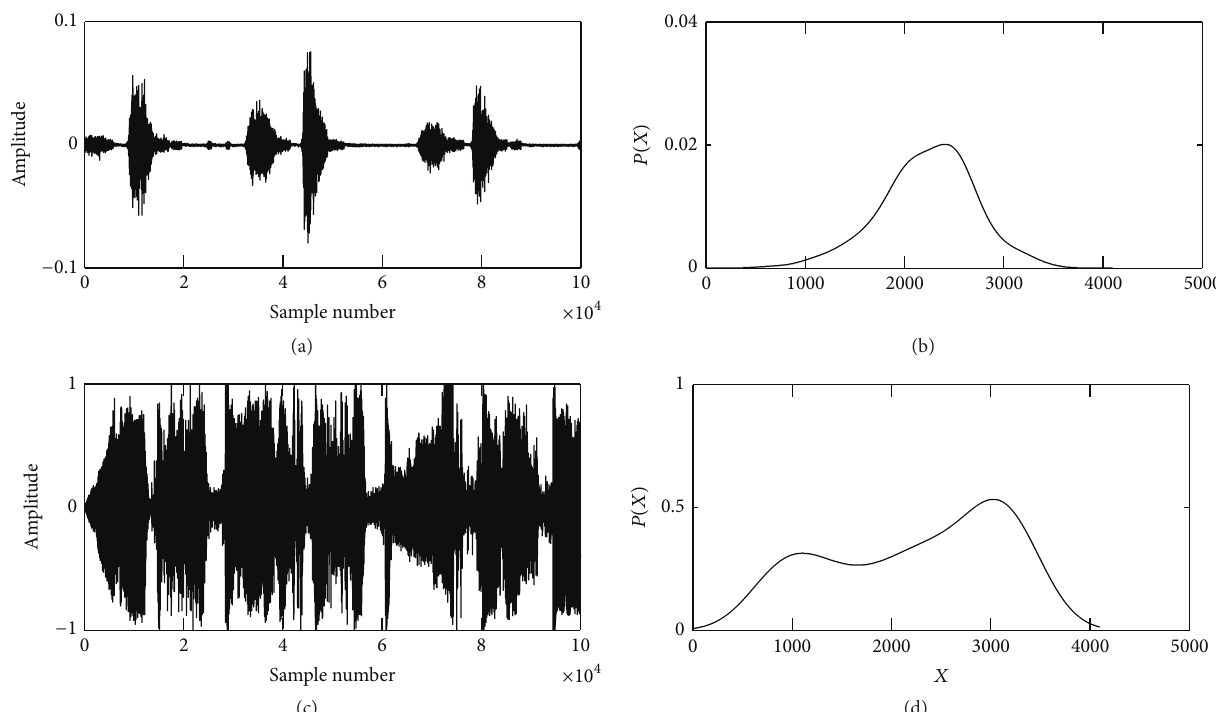
Figure 5: (a) and (c) display the normal and abnormal lung sound waveforms. (b) and (d) show the probability distribution functions for normal and abnormal